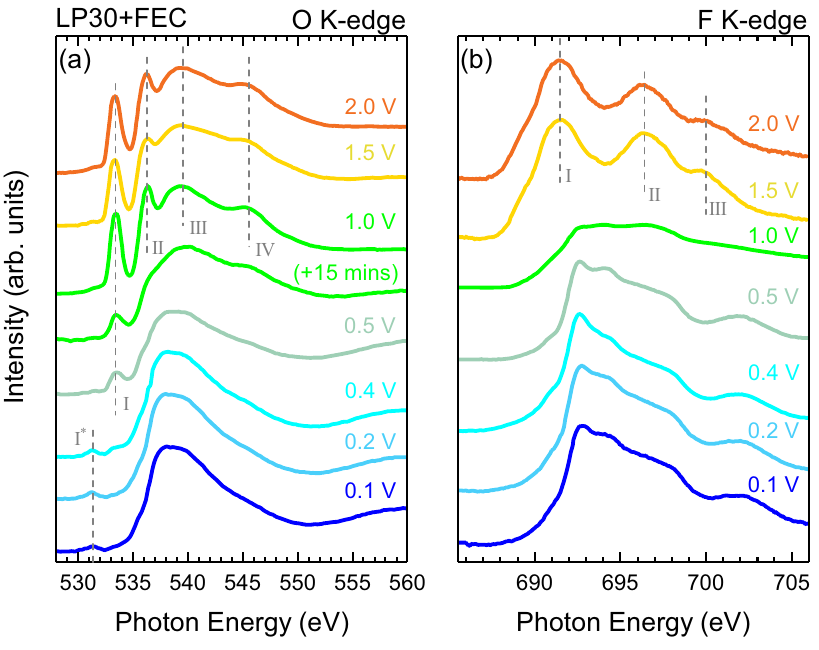
Fig.6| Operando TEY-XASwithFECadditive. TEYXASof( a )theOK-edgeand( b ) F K-edge taken during cycling at different potentials ranging from 2.0V down to